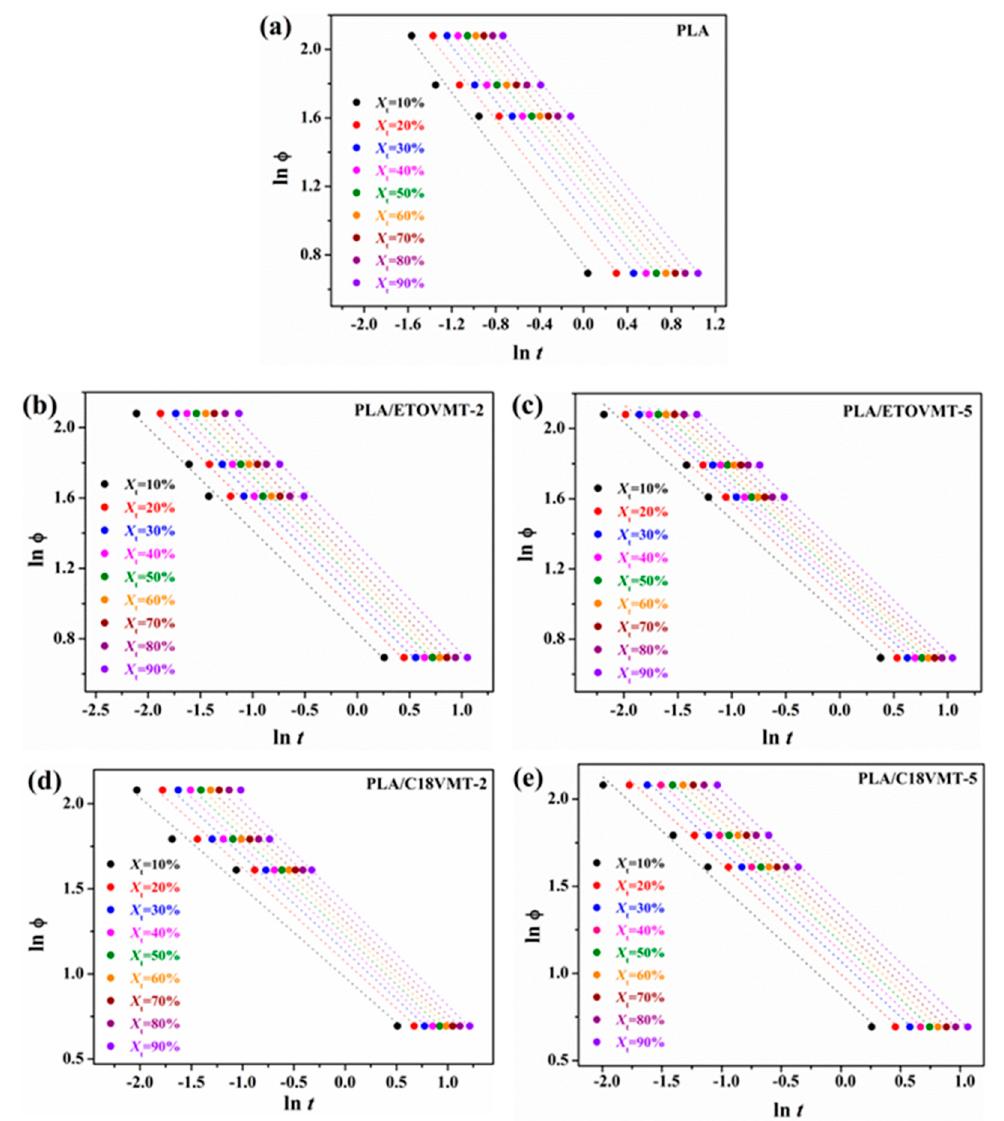
Figure 10. Plots of ln φ vs. ln t for the non-isothermal cold crystallization of ( a ) PLA, ( b ) PLA/ETOVMT-2, ( c ) PLA/ETOVMT-5, ( d ) PLA/C18VMT-2, ( e ) PLA/C18VMT-5.